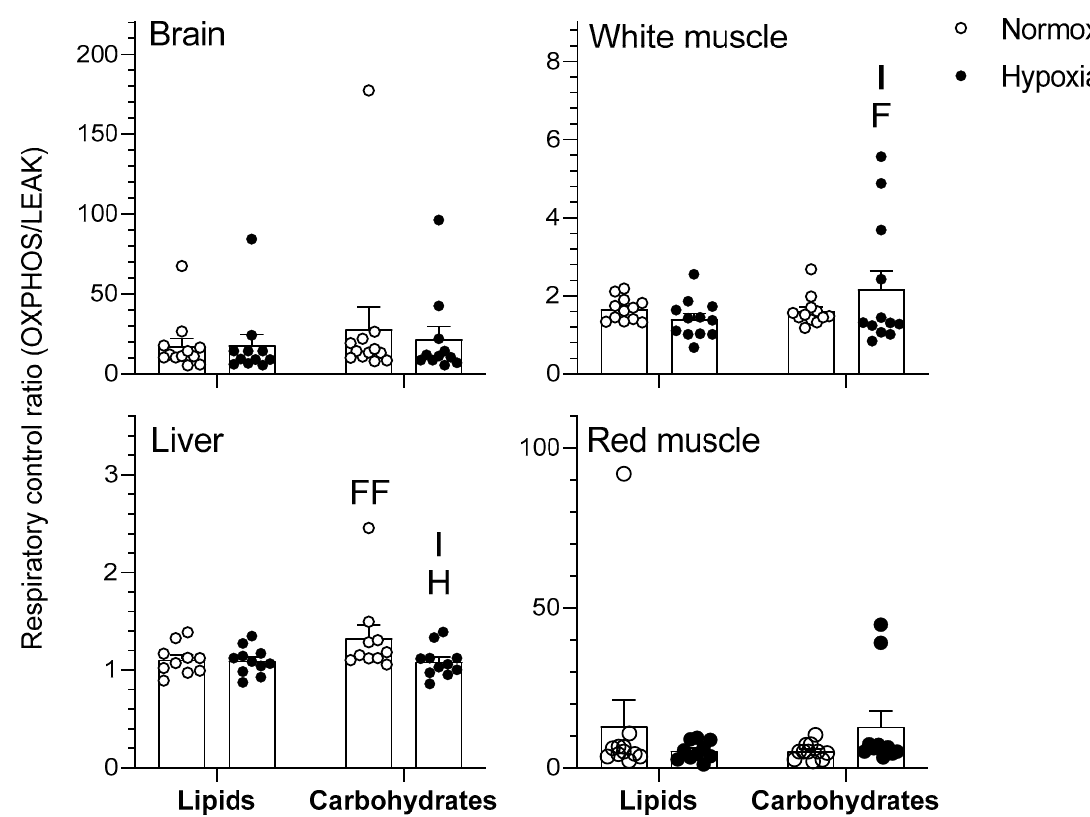
Figure 3. Respiratory control ratio (RCR) in the tissues of normoxic controls ( N = 12) and hypoxia-acclimated goldfish ( N = 11). RCR was calculated as the ratio between OXPHOS respiration and LEAK respiration (OXPHOS/LEAK). Values are means ± s.e.m. Dots represent individual data points. Differences between fuels are indicated as F ( p < 0.05) and FF ( p < 0.01). Difference between oxygen levels is indicated as H ( p < 0.05). Significant interaction between type of fuel and oxygen is indicated as I ( p < 0.05).